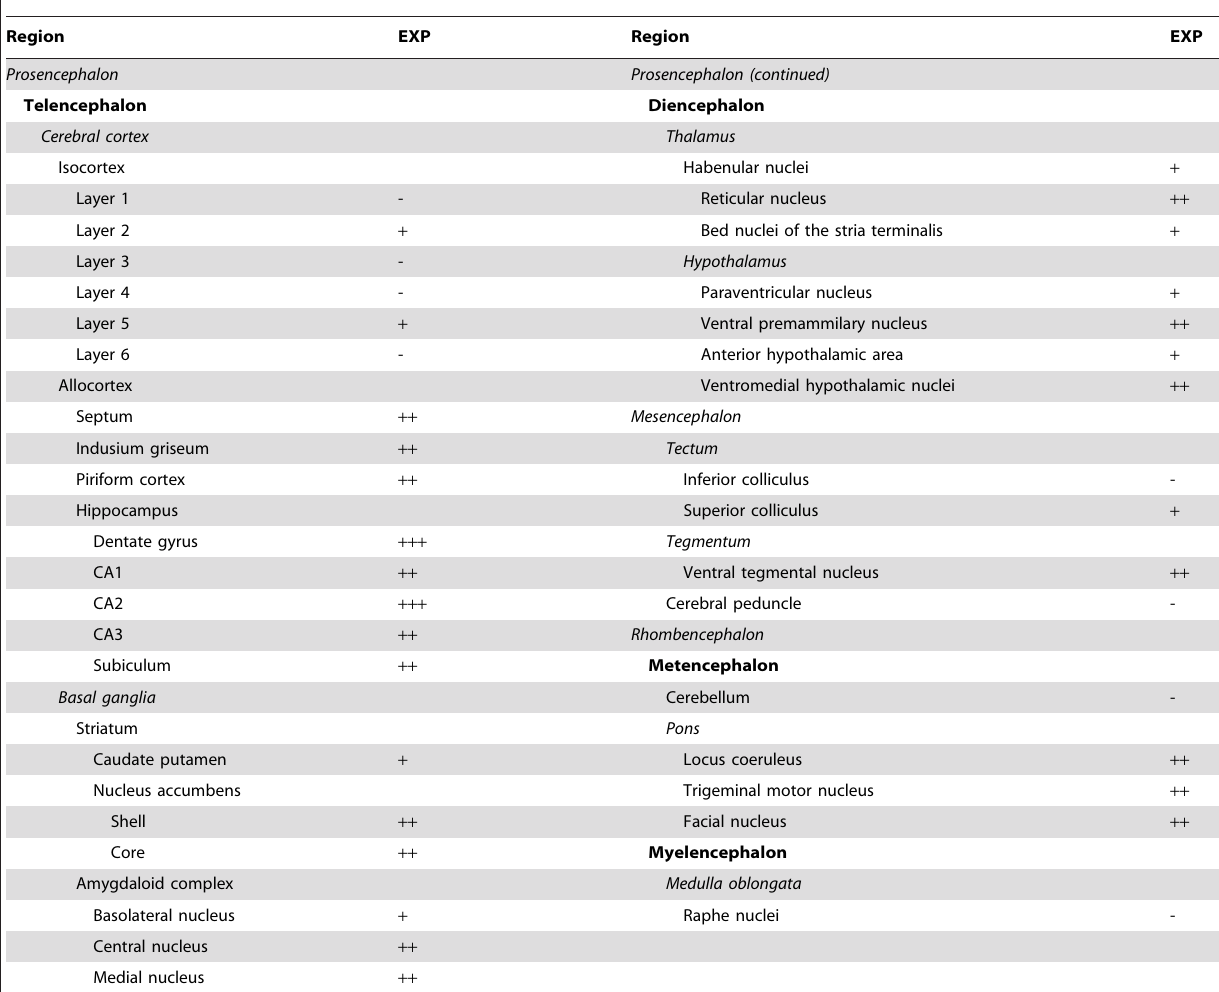
Table 1. Systematic overview of basal Fkbp5 mRNA expression.